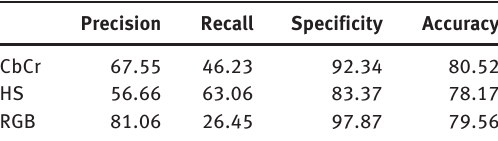
Table 1. Accuracy Results for CbCr, HS, and RGB on the UCD Database.